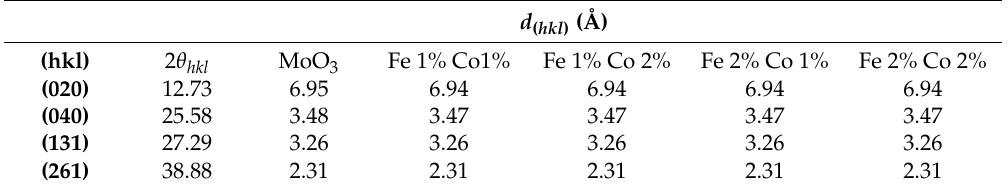
Table 1. Interplanar distance d ( hkl ) of the MoO 3 : Fe-Co thin film with different codopant composition.